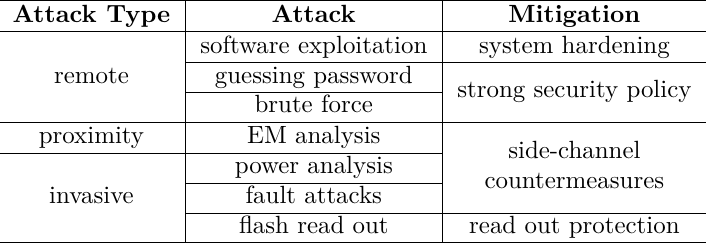
Table 2: Summary of the attack types specific to the